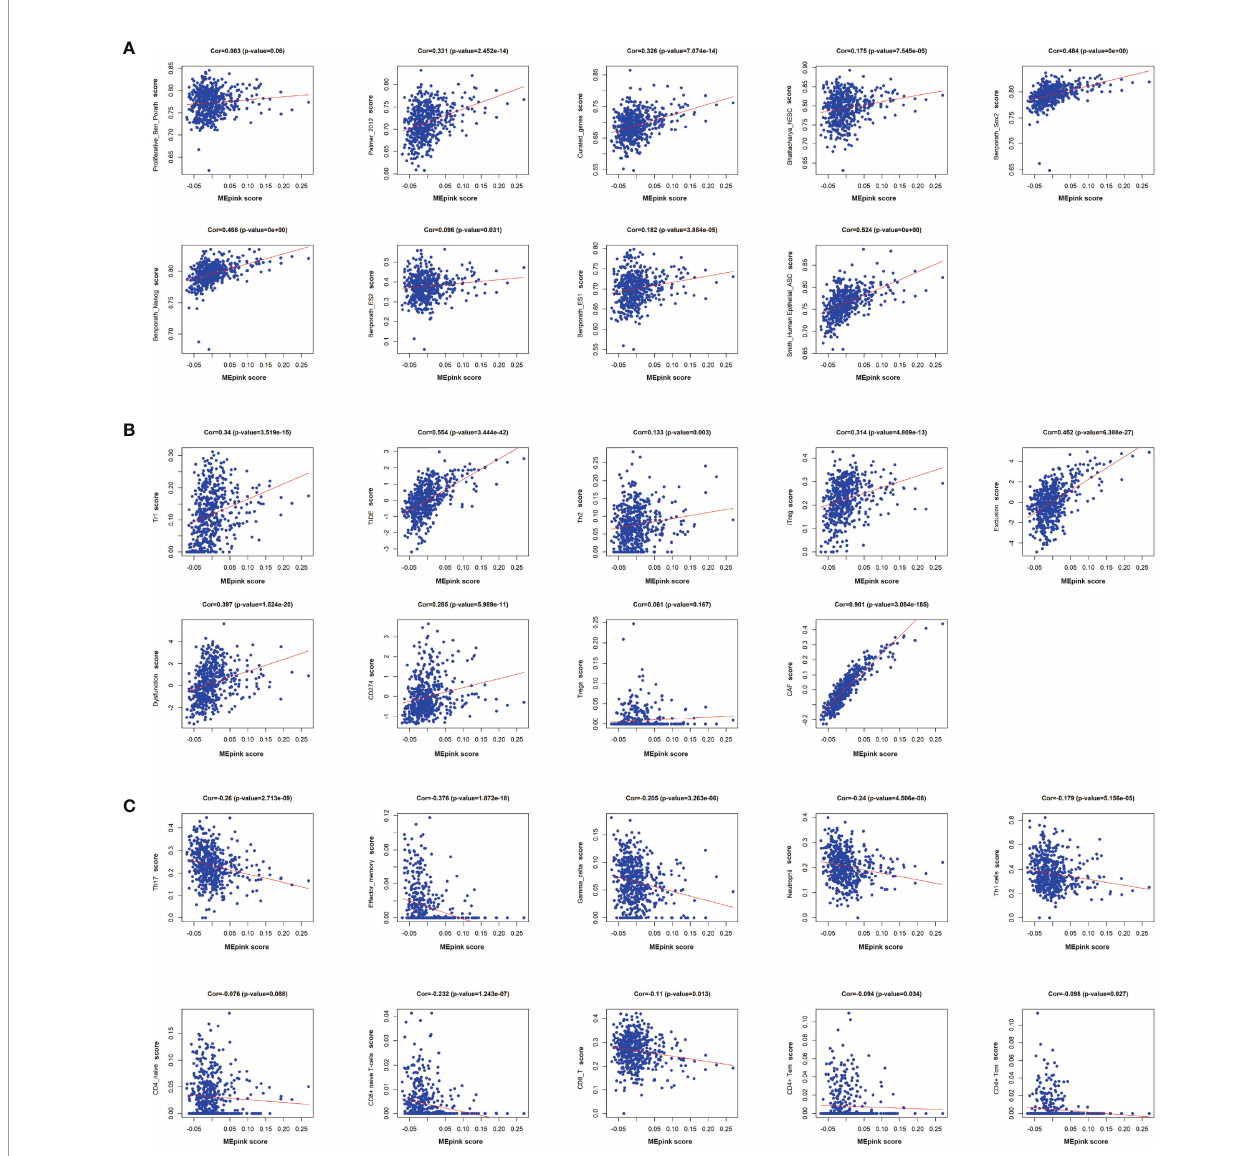
FIGURE 4 | Correlation of signi fi cant genes in pink modules with stemness and immunotherapy resistance. (A) Correlation analysis of pink modules with markers of cancer stemness. (B) Correlation analysis of pink modules with immune suppressive markers. (C) Correlation analysis of pink modules with immune stimulative markers. Cor,